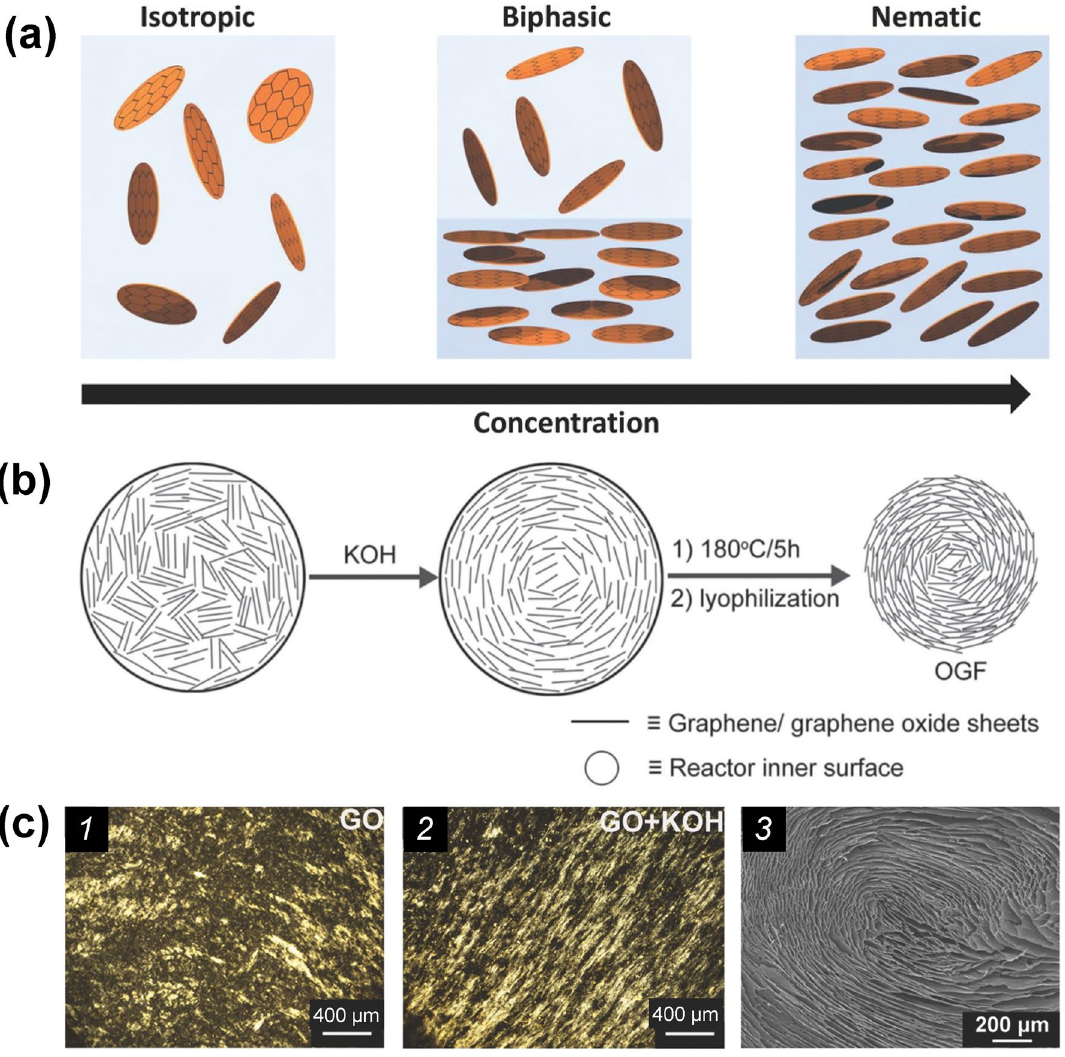
Fig. 9 a Schematics of the phase transition of GO liquid crystal with the increase in concentration [171]. b Microscopic schematics of the formation of the anisotropic graphene 3D network by the orientation of GO liquid crystal [175]. c Polarized‑light optical microscope and SEM images of the anisotropic graphene 3D network formed by the orientation of GO liquid crystal